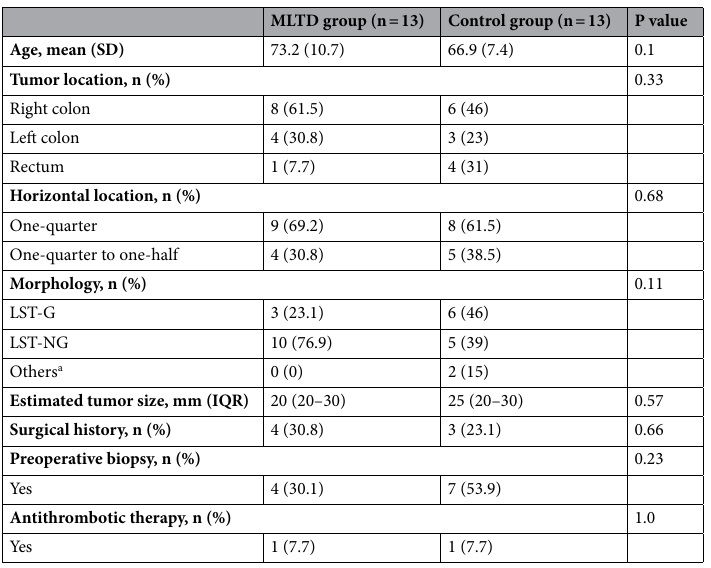
Table 1. Patient characteristics. SD standard deviation, IQR interquartile range, LST-G laterally spreading tumor granular type, LST-NG laterally spreading tumor non-granular type. a Refers to 0-Is lesions that could not be classified as laterally spreading